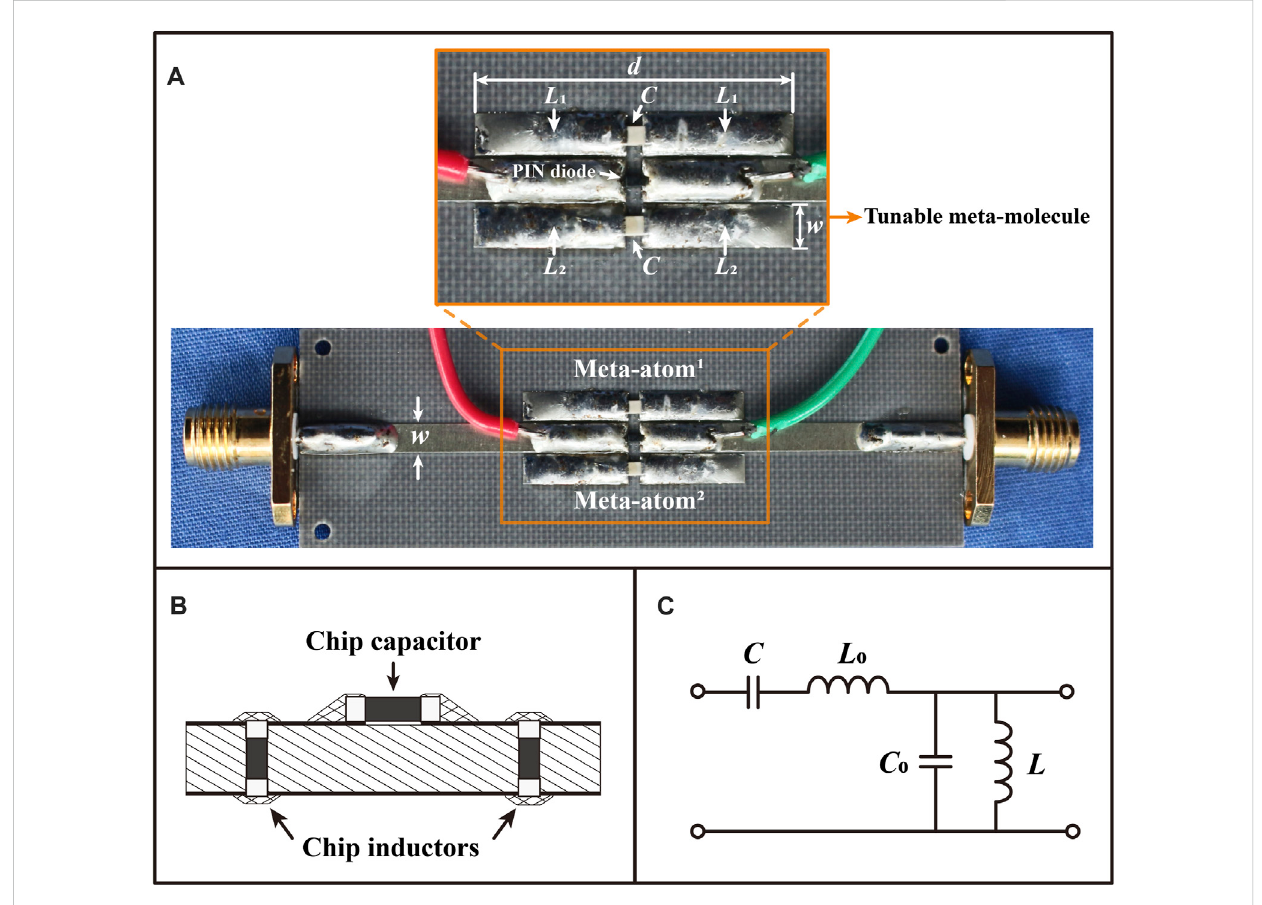
FIGURE 2 (A) Photograph of the fabricated electrically tunable SEC-like molecule. The (B) schematic model and (C) circuit model of ZIM-based meta-atom with the loading chip capacitor and chip